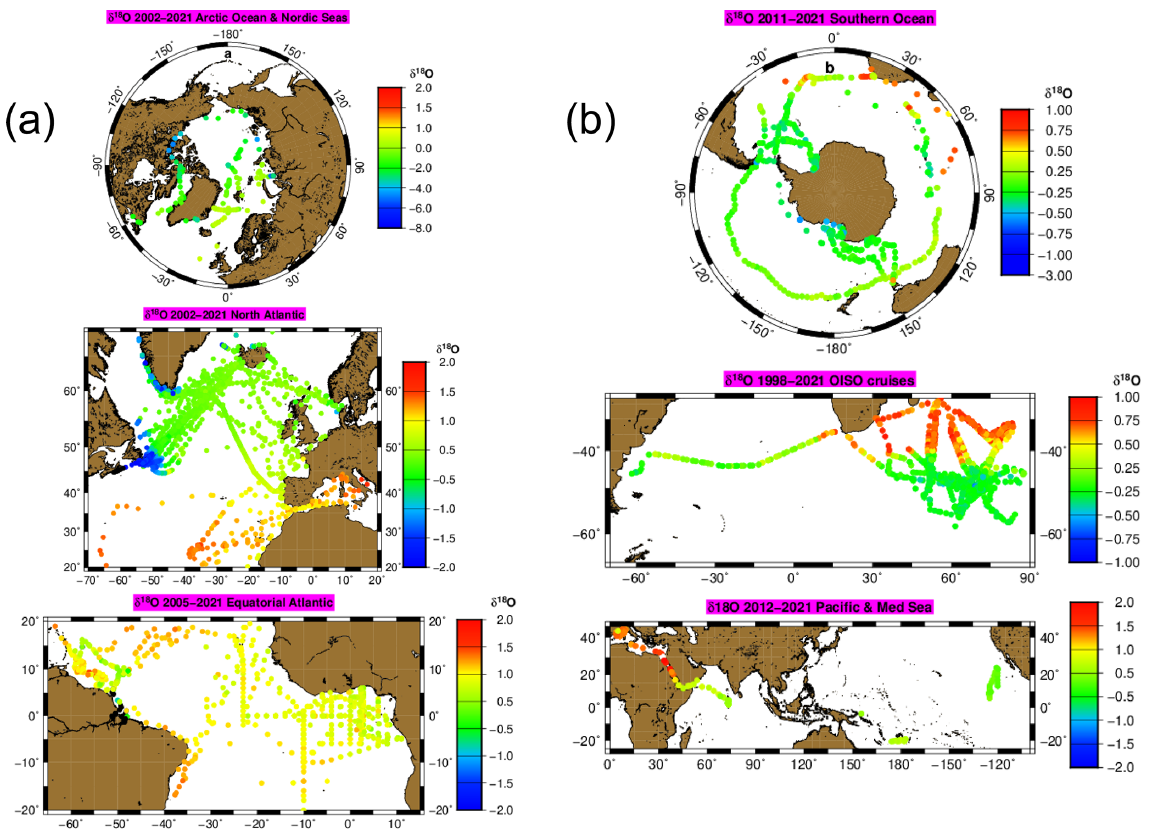
Figure 3. Maps which include most of the near-surface δ 18 O data in the LOCEAN archive (color scale δ 18 O in ‰). (a) Arctic and Atlantic oceans; (b) other oceanic